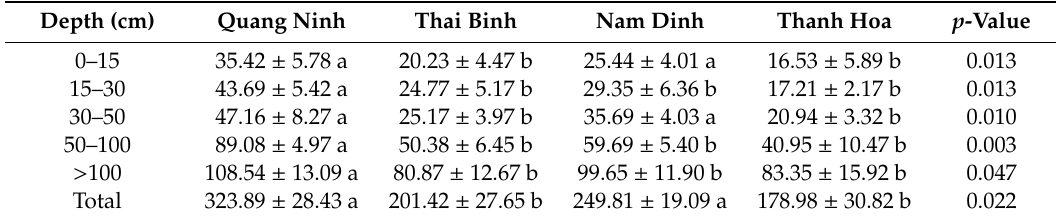
Table 4. Soil carbon pools (mean ± SE) (Mg / ha) according to provinces in the study area. The letters in each row denote the di ff erences among